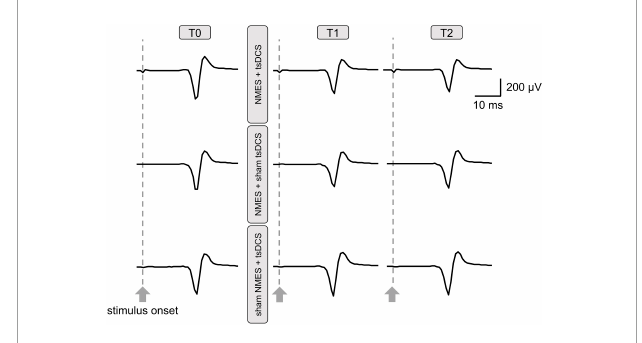
FIGURE4 Raw traces of posterior root muscle reflex (PRMR) waveforms from the right tibialis anterior muscle were obtained from a participant before and after neuromuscular electrical stimulation (NMES) + transcutaneous spinal direct current stimulation (tsDCS); NMES + sham tsDCS; and sham NMES + tsDCS. Each waveform represents the average of five trials.